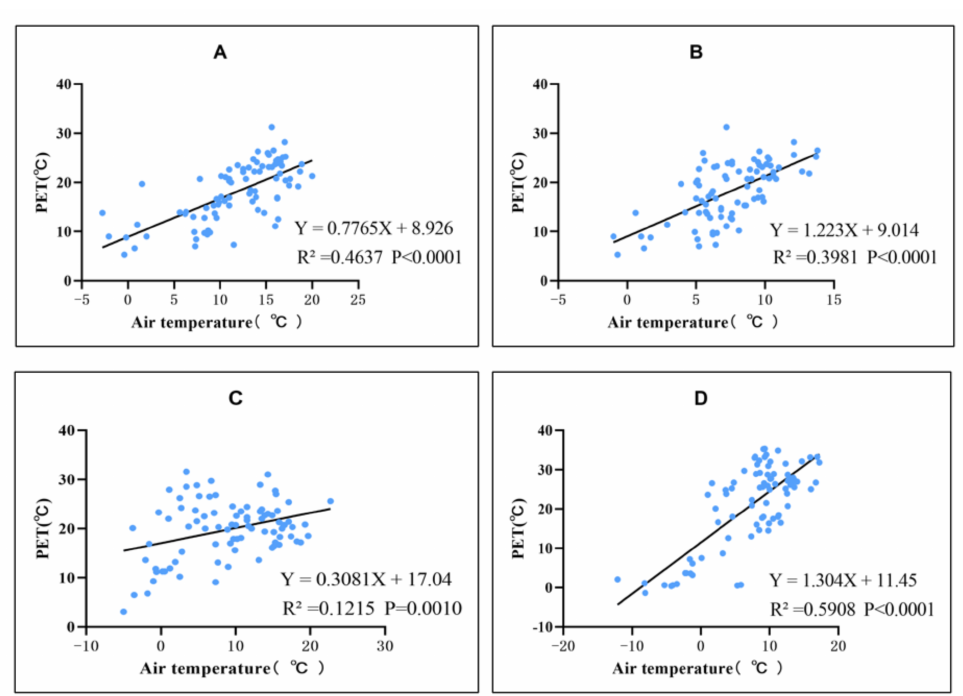
Figure 12. The relationship between PET and air temperature in different courtyards. (( A – D ) respec- tively represent the number of the courtyard under